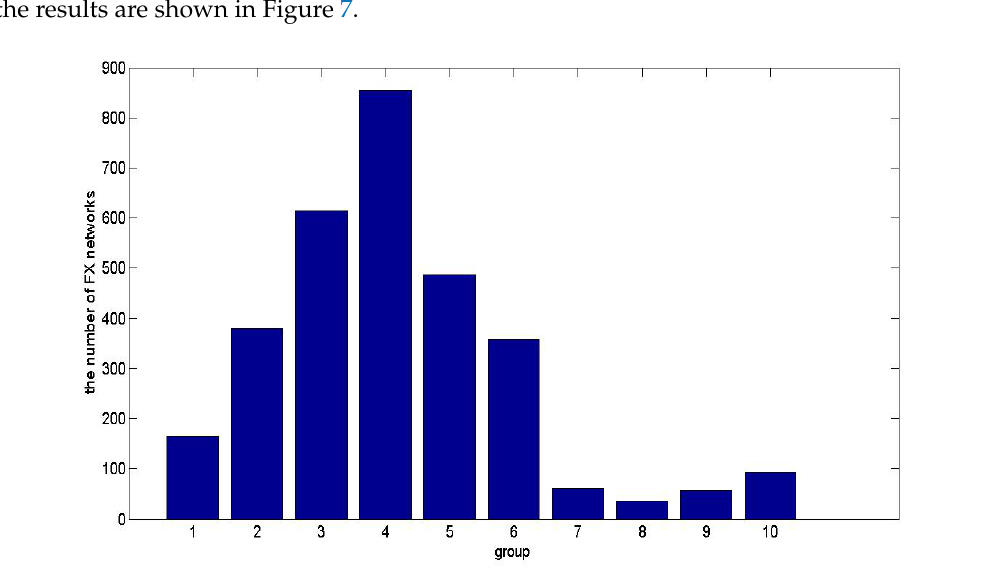
Figure 7. The quantity of FX networks in each group according to the average return volatility of the FX market index with the corresponding time